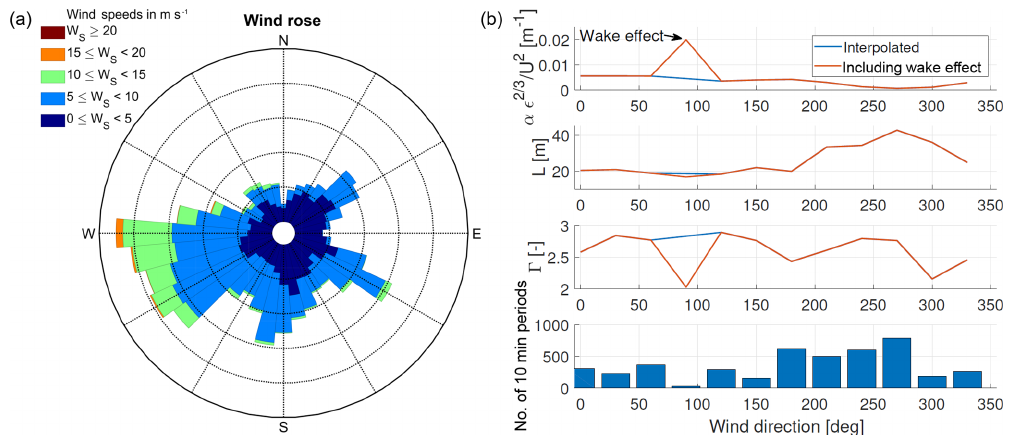
Figure 5. (a) Wind rose gathered during the test periods at the Risø test site. (b) The three top panels show the result of fitting the Mann model to the calculated mean spectra as a function of wind direction. The bottom of panel (b) shows the number of acquired 10min periods as a function of wind